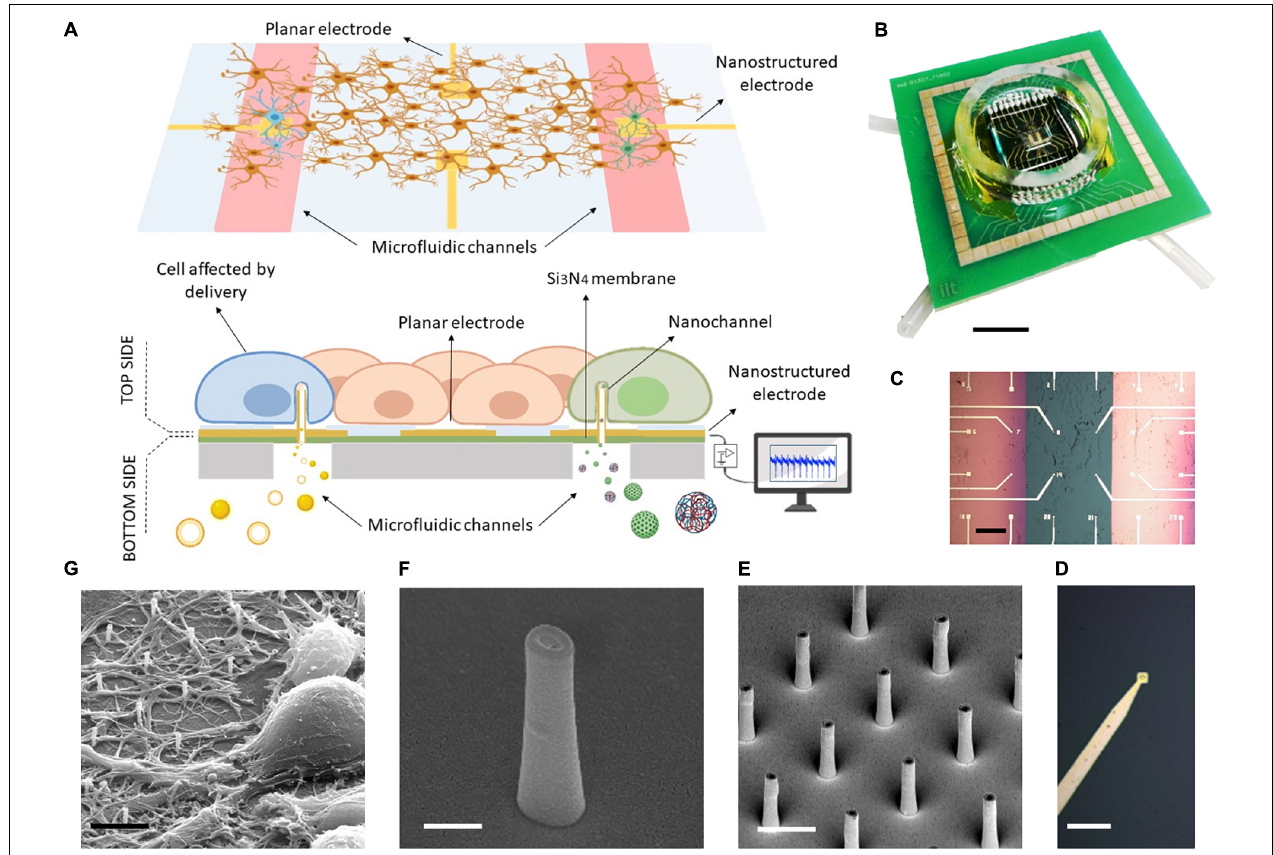
FIGURE 1 | MF-MEA device. (A) Schematic of the device. (B) Top picture of the final device. Scale bar: 1 cm. (C) The top surface in detail, with feed lines and electrodes on thin silicon nitride membranes (pink) and bulk surface (green) Scale bar: 400 µ m. (D) Magnification of an electrode. Scale bar: 30 µ m. (E) SEM images of the hollow nanoantennas fabricated on the electrodes. Scale bar: 2 µ m. (F) Magnification of a hollow nanostructure. Scale bar: 500 nm. (G) SEM image of neurons cultured on the nanostructures. Scale bar: 5 µ